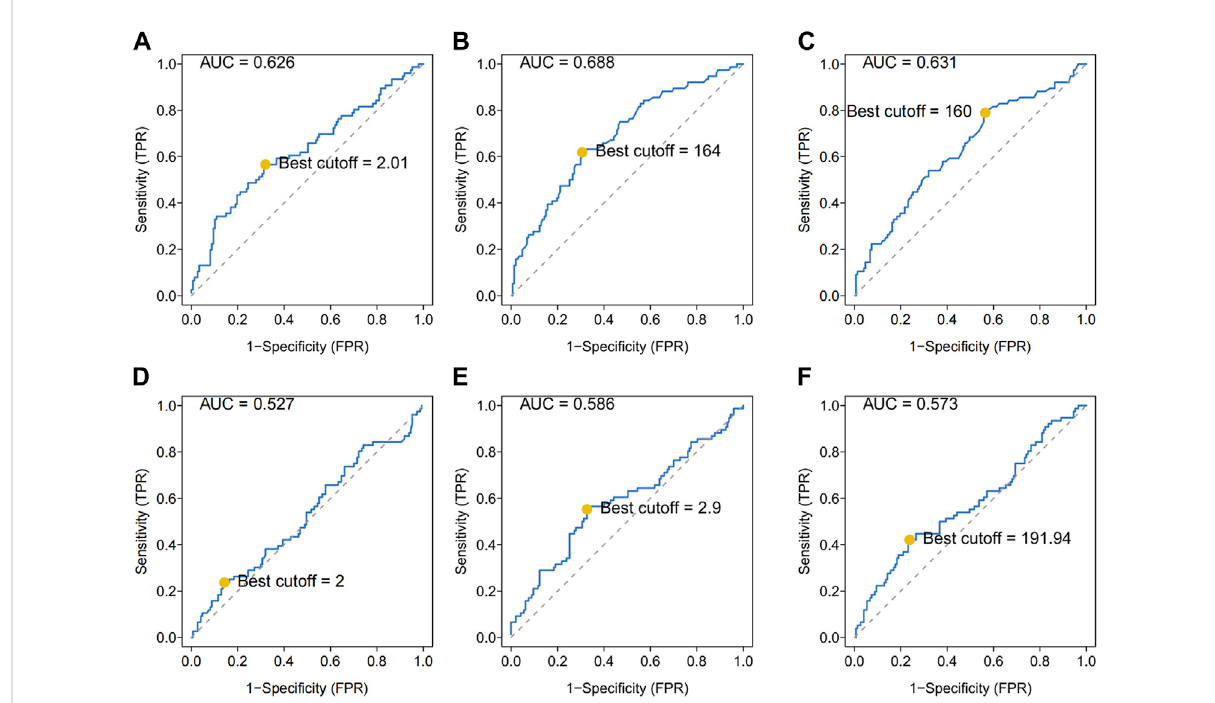
FIGURE 1 ROC analysis of different hematological biomarkers. (A – F) The AUC and best cutoff values of dNLR, LDH, HBDH, LMR, NLR, and PLR were shown, respectively. The vertical axis represents the sensitivity and the horizontal axis represents the 1-speci fi city. dNLR, derived neurtrophil to lymphocyte ratio; LDH, lactate dehydrogenase; HBDH, Hydroxybutyrate dehydrogenase; LMR, lymphocyte-monocyte ratio; NLR, neutrophil – lymphocyte ratio; PLR, platelet – lymphocyte